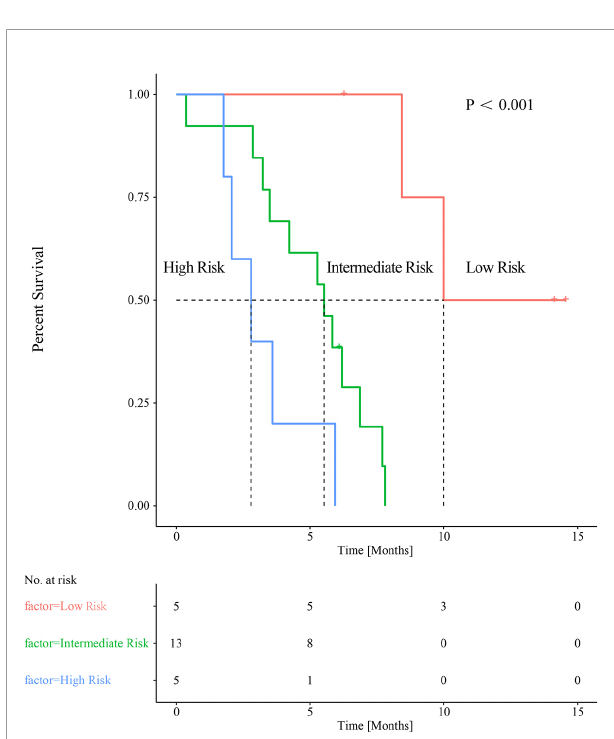
FIGURE 5 | Combinedbaseline SUVpeakandPreLMR resulting incategorization intothreedistinct groups ofpatients withsigni fi cantlydifferent